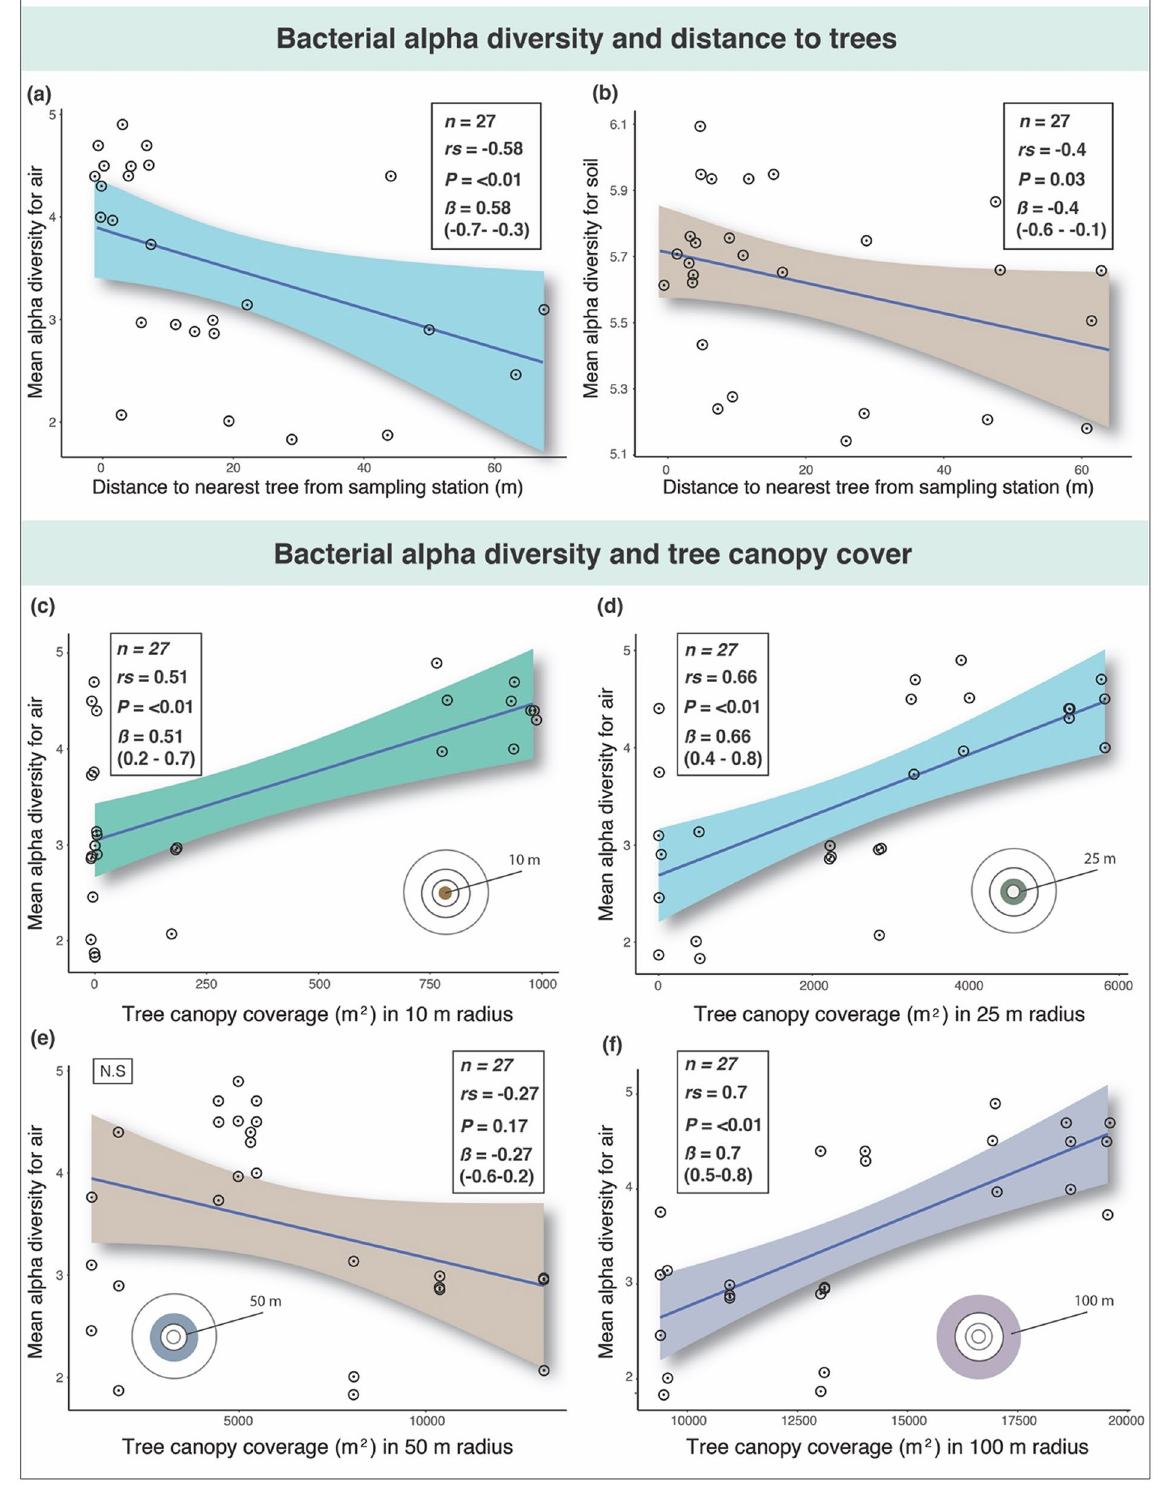
Figure 6. The upper panels show scatterplots of Spearman’s correlations (rs) between bacterial alpha diversity (for all habitats) and distance to nearest trees: ( a ) air-only samples, and ( b ) soil-only samples. X-axis shows distance (m) to nearest trees from sampling points. The lower panels show scatterplots of Spearman’s correlations between bacterial alpha diversity (for all habitats) and tree canopy coverage within the sampling point radii: ( c ) 10 m, ( d ) 25 m, ( e ) 50 m, and ( f ) 100 m. These relate to air-only samples. X-axis shows tree canopy coverage (m 2 ). Y-axis for both upper and lower panels shows bacterial alpha diversity of samples according to the Shannon diversity index (H). Coloured shading indicates the 95% confidence intervals for each linear regression. Inset also shows bootstrap results (β) with 2.5% and 97.5% slopes. N.S (not